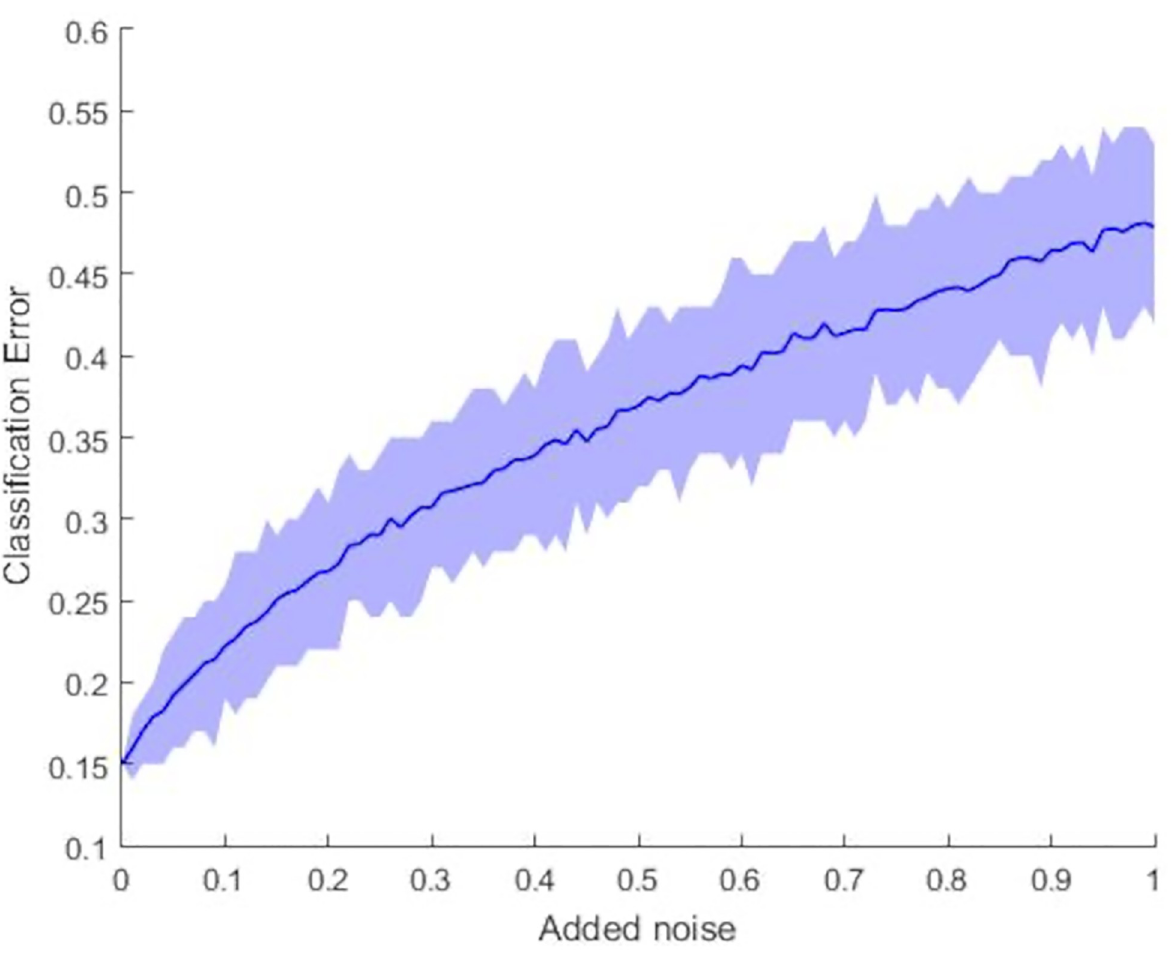
Fig 4. Classification error as a function of noise levels for the Kahraman dataset. This graph illustrates how the average classification error of the nearest-mean classifier performs for CDPA with the Kahraman dataset changes when the added noise levels are increased from 0 to 1. A 95% confidence band for classification error is also